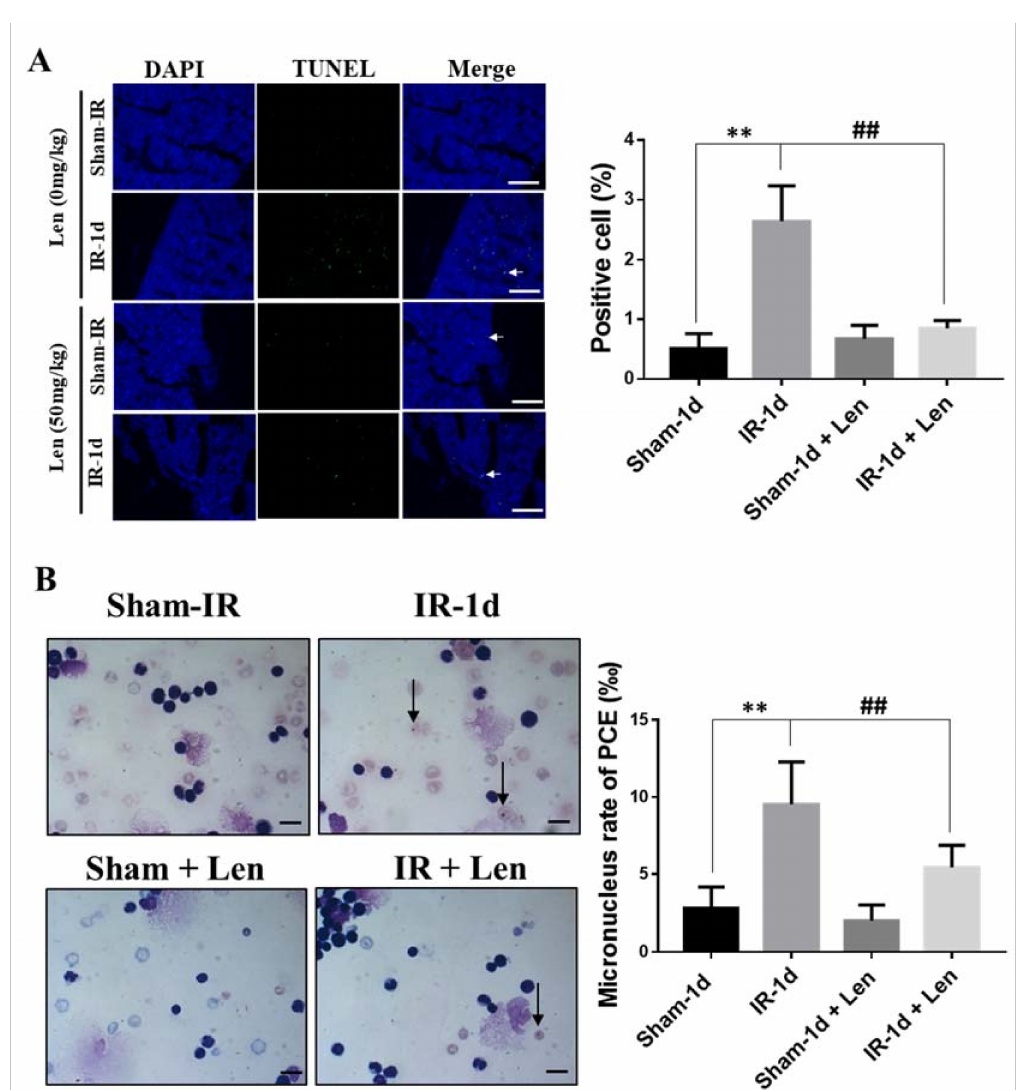
Figure 7. TNF- α contributes to the abscopal bone marrow damage in the Th-IR mice. Mice were pretreated with or without TNF- α inhibitor of lenalidomide (50 mg/kg, Len) by intraperitoneally injection before Th-IR (8 Gy × 3). The bone marrow of mice was collected at day 1 after Th-IR. ( A ) TUNEL staining and apoptosis rate of bone marrow cells. White arrows represent the TUNEL positively stained cells. Bar = 100 µ m. ( B ) PCEs staining and micronucleus formation. Black arrow, micronucleus of PCEs. ** p < 0.01 indicated a significant difference from sham group; ## p < 0.01 indicated a significant difference with the IR group. Bar = 10 µ m. n =